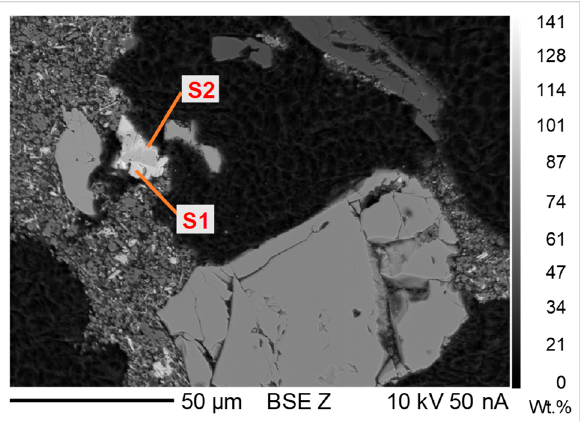
Figure 17. Backscattered electrons image of insoluble (Sr,Ba,Ca)SO 4 crystals marked with S1 and S2.